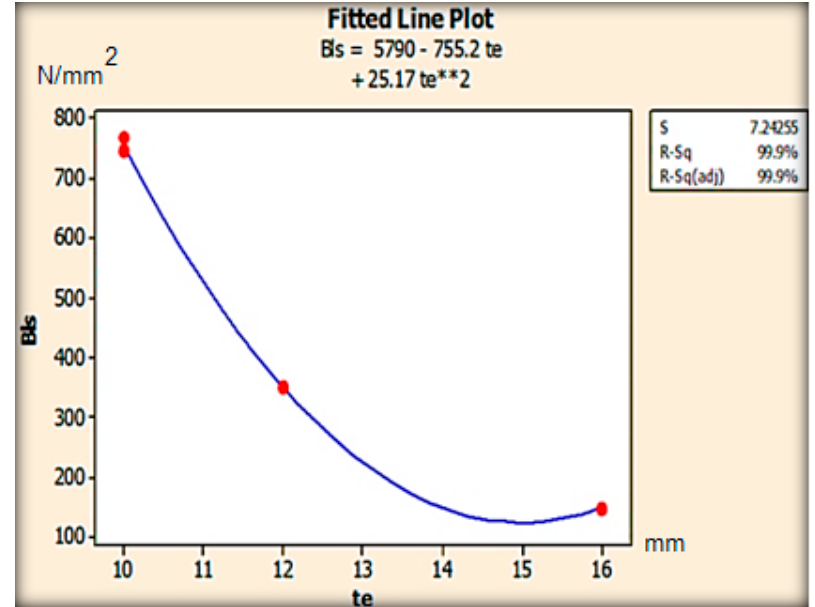
Figure 19. Variation of bending stress N/mm 2 , for different thickness of leaf spring.